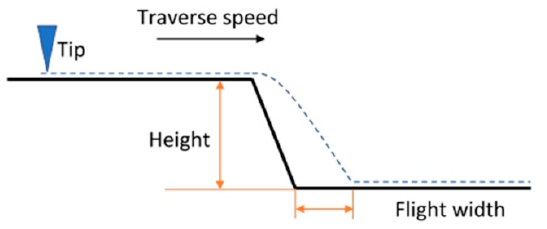
Figure 6. The tip flight test to measure the dynamic behavior of the microprobe.